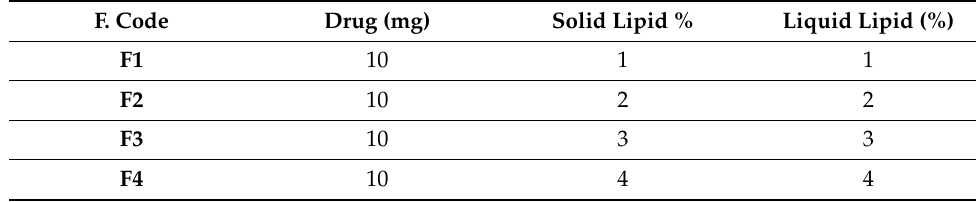
Table 7. The composition of the prepared